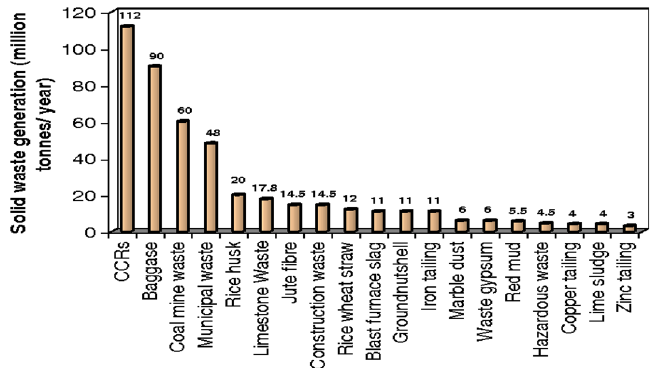
Figure 1. Solid waste generation in India (Million tones/year).